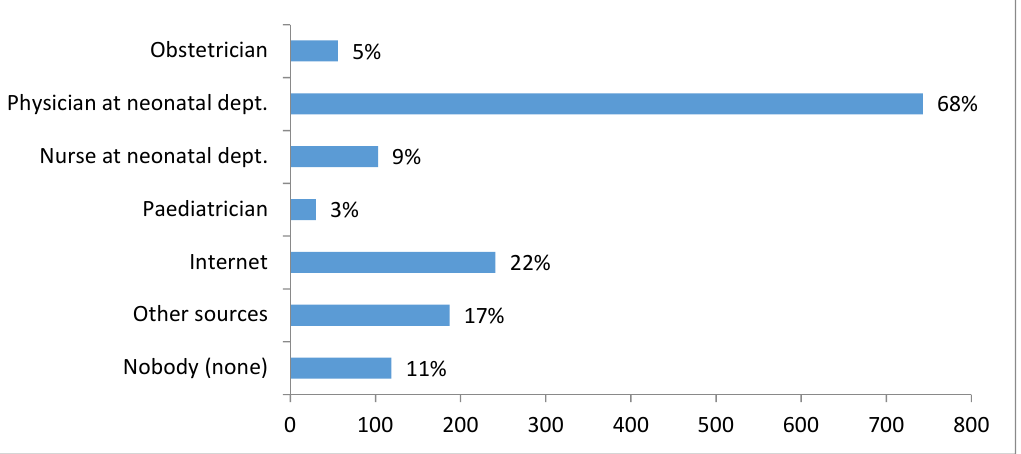
Figure 3. Sources of NBS information reported by participants.